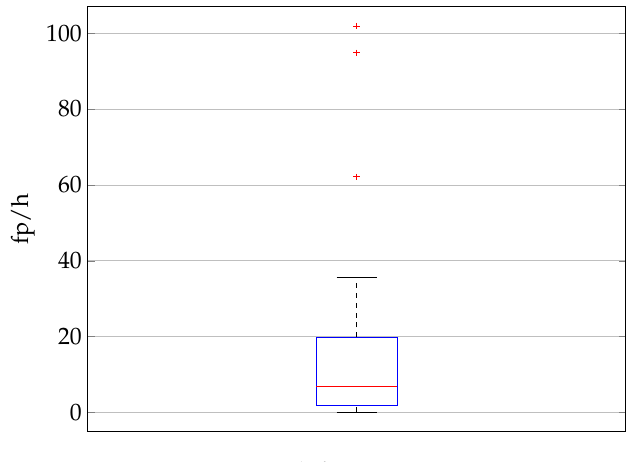
Figure 6. Illustration of the specificity of the classification showing a boxplot (median value (red), lower and upper quartile (blue), min. and max. value (black), outlier (red cross)) of the fp/h for 20 patients. The median fp/h is 6.8, 75 percentile: 19.8, 25 percentile: 1.75. The analysis is done on time signals with a length of 1 s. A false positive rate of 6.8 fp/h corresponds to a specificity of 0.998, this means that 99.8% of inter-ictal time frames of 1 s are classified